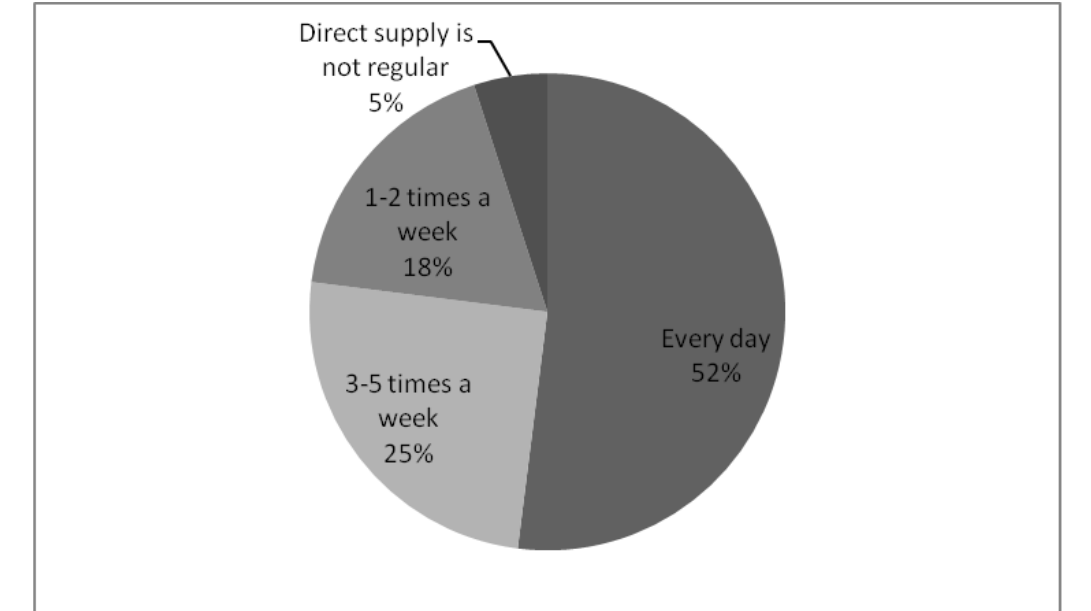
Figure 2. The results of the answer to the question “Do you eat at the same Table 3. Percentage Distribution of the Main Criteria by Which Athletes are Selected Products